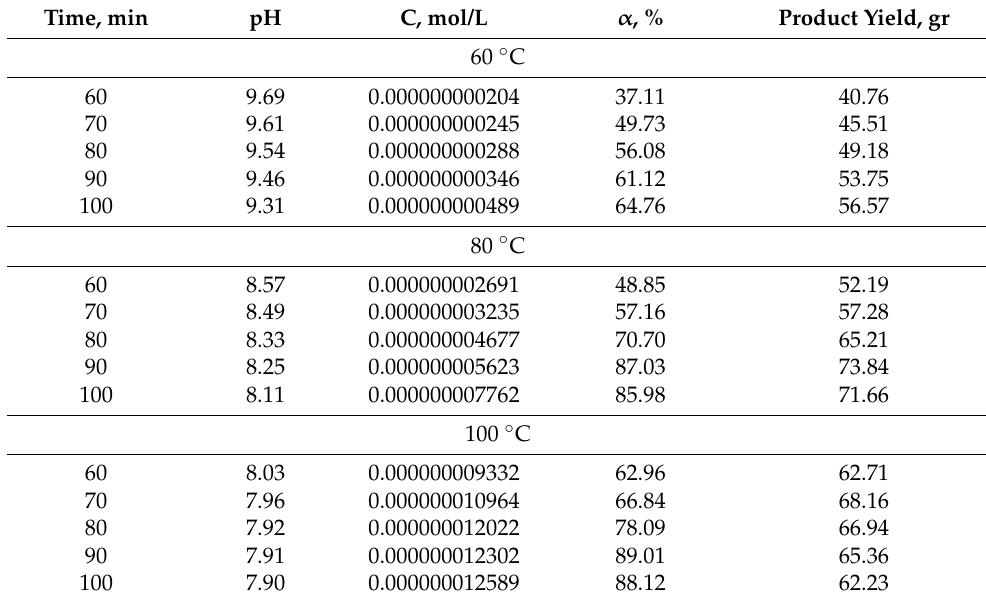
Table 4. Results of experimental studies on the extraction of potassium humate.